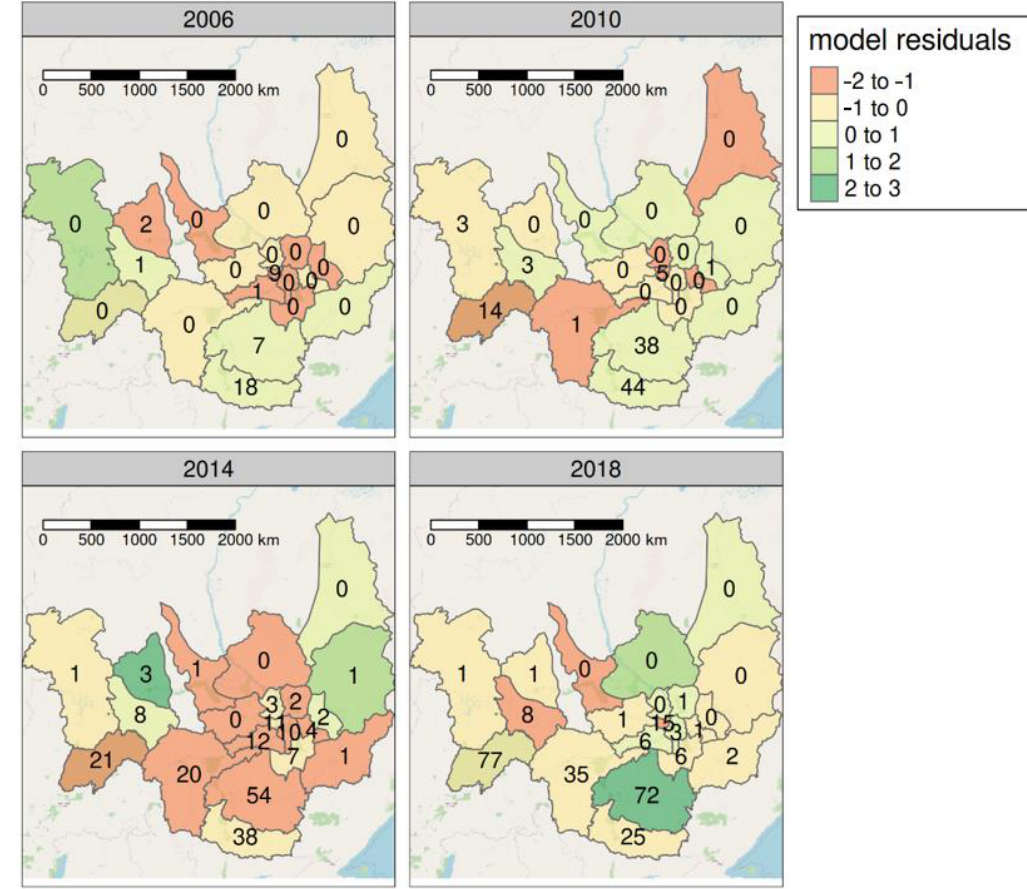
Figure 7. Polygons are districts in Sakha. Red color means the model over estimated the number of cases, green color means the model underestimated the number of cases. The numbers in the polygons are the number of observed tick bite cases in the corresponding year.